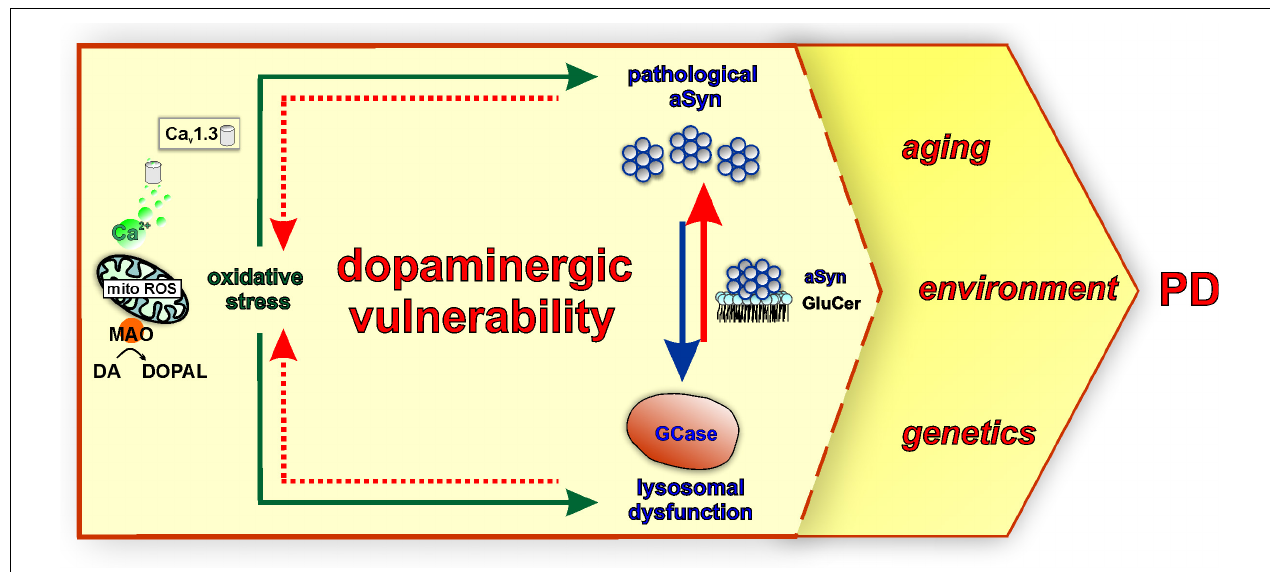
FIGURE 3 | Mitochondrial oxidative stress, lysosomal dysfunction, and pathological aSyn are major converging pathways in the vulnerability of SNpc DAergic neurons in PD. Calcium influx via Ca v 1.3 channels during pacemaking and the metabolism of DA to DOPAL by mitochondrially-anchored MAO support mitochondrial energy production under physiological conditions. However, these mechanisms could also represent a dual source of sustained mitochondrial oxidative stress (mito ROS) over a long period, contributing to PD SNpc vulnerability. Moreover, DA metabolism and neurotoxic DA metabolites including DA/DOPAL quinones exacerbate oxidative stress and are linked to pathological aSyn modifications and GCase inhibition (green arrows). In turn, GCase is reciprocally linked to pathological aSyn via its lipid substrate glucosylceramide (GluCer). GCase deficiency increases GluCer levels, therefore stabilizing oligomeric aSyn intermediates (red arrow), whereas pathological aSyn inhibits GCase lysosomal activity or trafficking (blue arrow). As part of this vicious feedback cycle, both GCase and pathological aSyn contribute to oxidative stress (intermittent red arrow) via intersecting with DA metabolism. These major pathways may render SNpc DAergic neurons more vulnerable to the influence of PD-linked factors, such as aging, environment, and